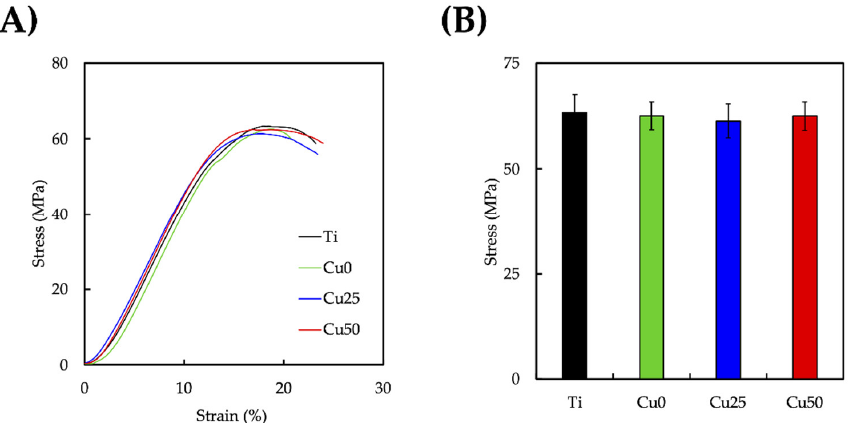
Figure 6. ( A ) The stress–strain profile and ( B ) the breaking point of various 3D-printed Ti6Al4V scaffolds. Data presented as mean ± SEM, n = 6 for each group.